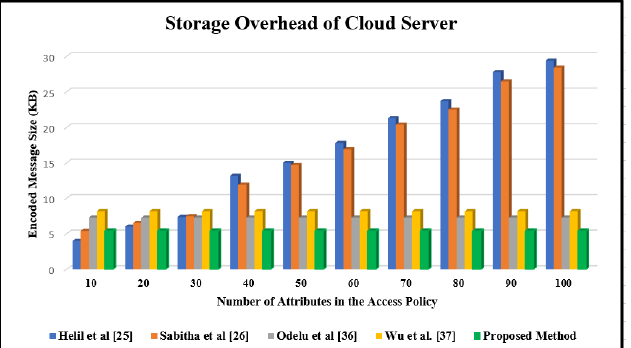
Figure 11. Encrypted file size in the cloud